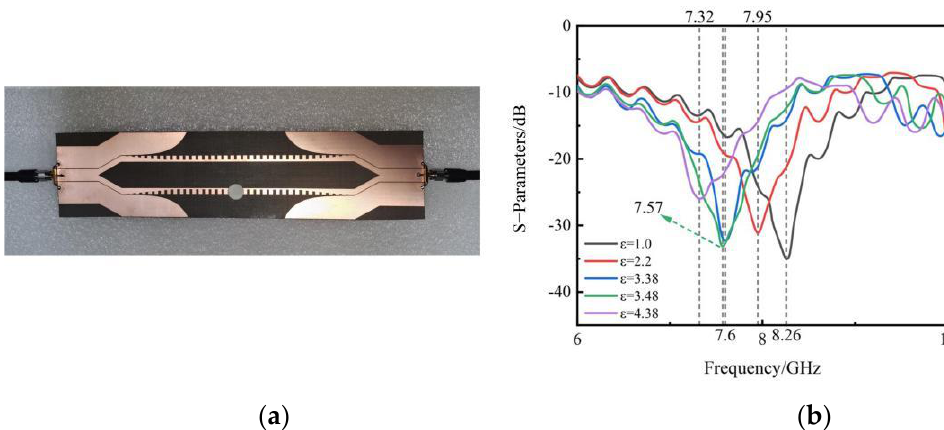
Table 1. Error analysis of calculated and actual permittivities.